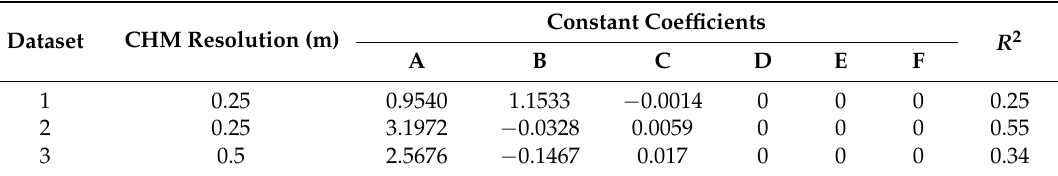
Table 4. Estimation of the variable-sized window for ITD. 316